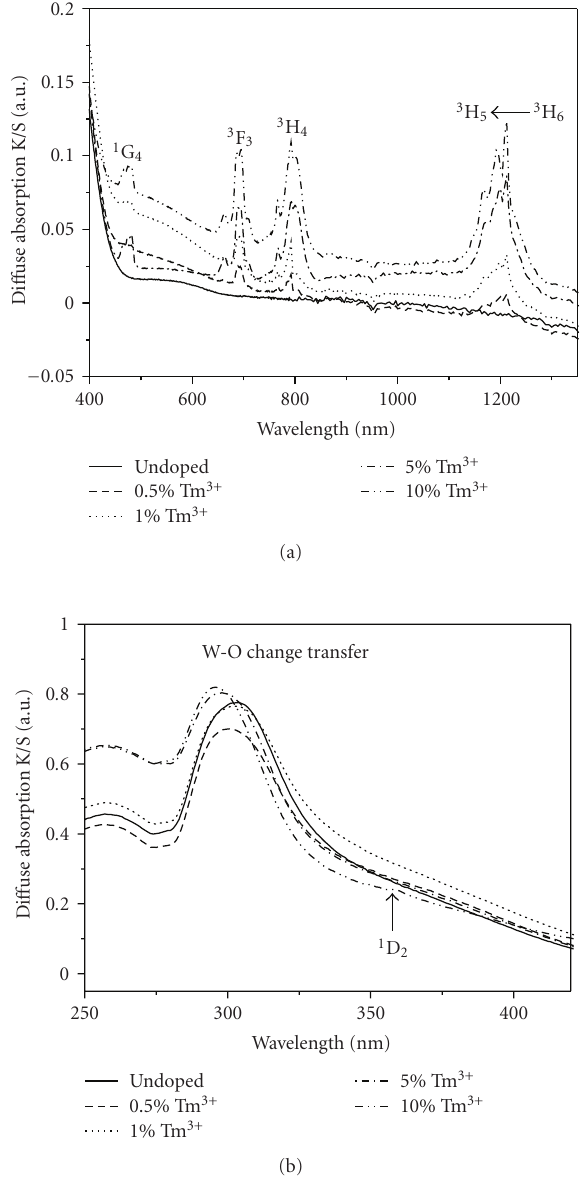
Figure 5: Di ff use absorption spectra LiIn 1 − x Tm x (WO 4 ) 2 ( x = 0, 0.5, 1, 5, and 10 at.%): (a) visible and (b) UV regions.